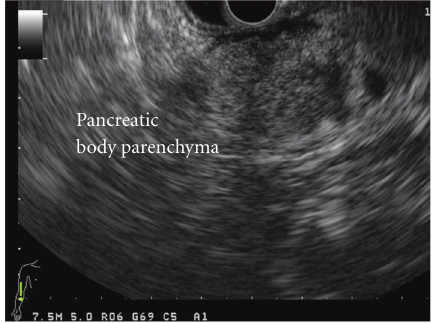
Figure 1: Linear EUS showing an inhomogeneous hypoechoic mass with irregular borders in the head of the pancreas. The echotexture of the pancreatic parenchyma appears heterogeneous with a coarse reticular pattern. A single pancreatic duct (PD) with a maximal diameter of 4 mm could be delineated in the head of the pancreas, appearing uniform with anechoic margins. A patent portal vein (PV) was also depicted bellow the PD with no evidence of tumor invasion.